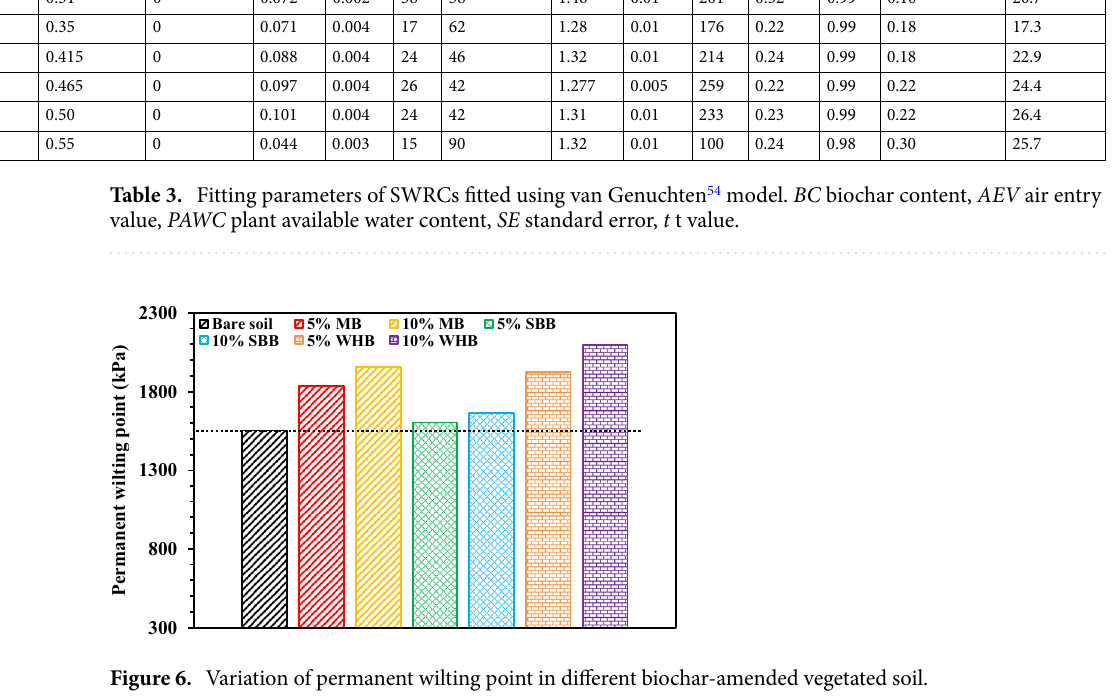
face. The final VD was observed to be higher in BAS relative to bare soil, except the WHB-amended soil that have exhibited relatively lower VD compared to bare soil. The amendment of biochar decreased dry density (Table 2), and increased water retention capacity i.e., higher plant available water (Fig. 5, Table 3), pH and EC (Table 2) of the soil which have enhanced the growth of roots and vegetation or VD. The total dry root mass presented in Fig. 8a was found to be higher in BAS compared to the bare soil. The higher roots mass in BAS is beneficial as these could provide more anchorage to the top soil against erosion and failure. The decrease of soil dry density or increase of porosity facilitates the roots to easily penetrate through soil without resistance. Further, the root mass density (RMD, Fig. 8b) showed a gradual decrease along the depth in both bare and BAS. The grass species tested in the present study had fibrous root system due to which most of the roots were grown at the top surface. In addition, the higher soil confinement along the depth restricted the root growth at the deeper depth. The shoot and root mass of a grass ( cynodon dactylon ) was found to be increased after 2 years of monitoring due to amendment of peanut shell biochar 38 . Similar higher growth of root and shoot were also reported by Ng et al. 36 for schefflera arboricola grown in peanut shell and wood biochar-amended soil.